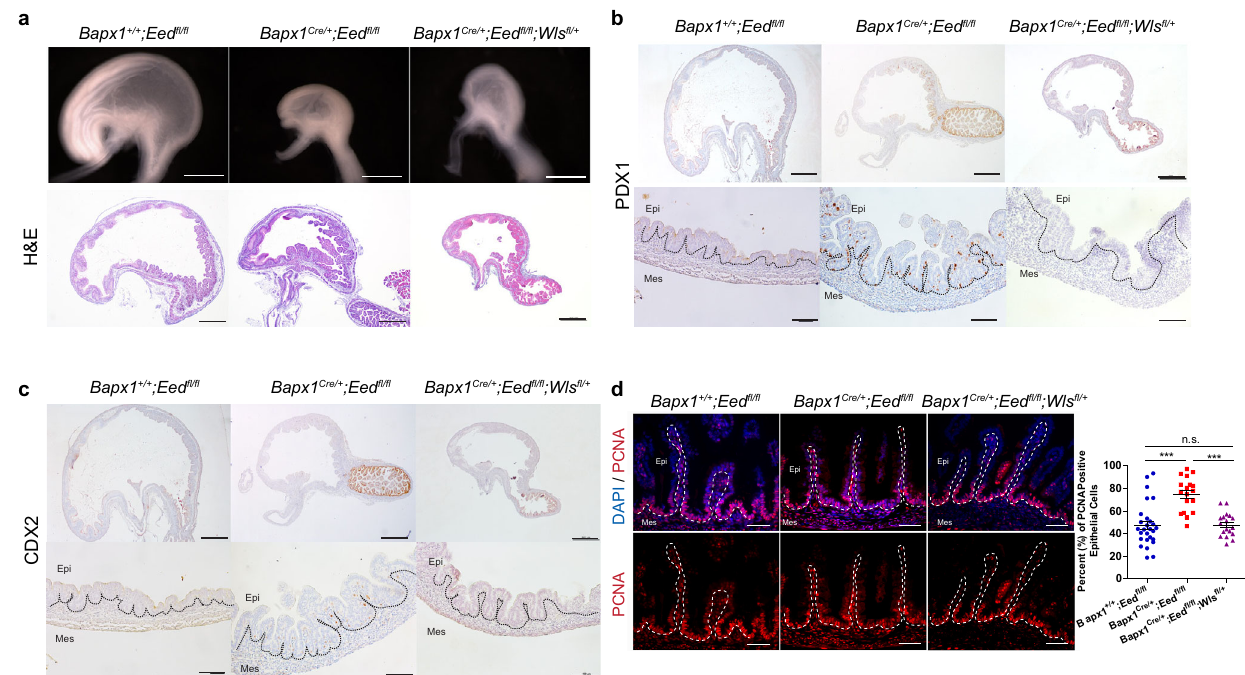
Fig. 4 | Reduced mesenchymal Wnt secretion restores gastric fate and intest- inalproliferationinepithelialcells.a – d Bapx1 +/+ ; Eed fl / fl mice(left), Bapx1 Cre/+ ; Eed fl / fl mice (middle), and Bapx1 +/+ ; Eed fl / fl ; Wls fl /+ mice (right). a Whole mount imaging and Haematoxylin and Eosin staining demonstrating gastric morphology of each gen- otype ( n =3 biologically independent samples for each genotype). CDX2 ( b ) and PDX1 ( c ) immunohistochemistry showing regionalization pattern in hindstomachs of mice ( n =3 biologically independent samples for each genotype). d PCNA immuno fl uorescence shows proliferation patters for each genotype. Epithelial